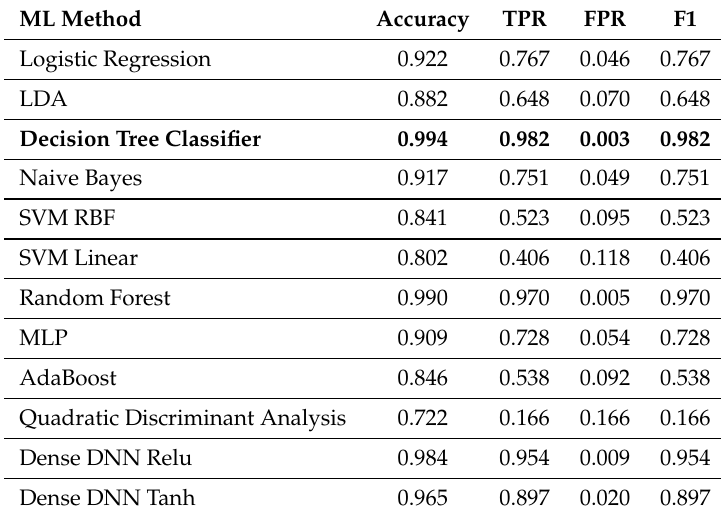
Table 1. Evaluation Results of the First ARIES Detection